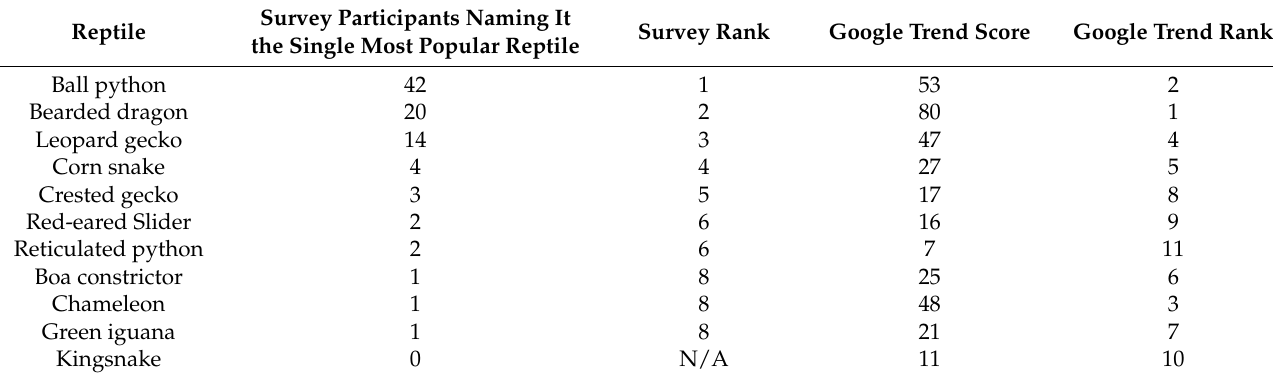
Table 1. The top ten most popular reptiles as indicated by an online survey and Google Trends. The Google Trend score represents the average relative monthly search interest for